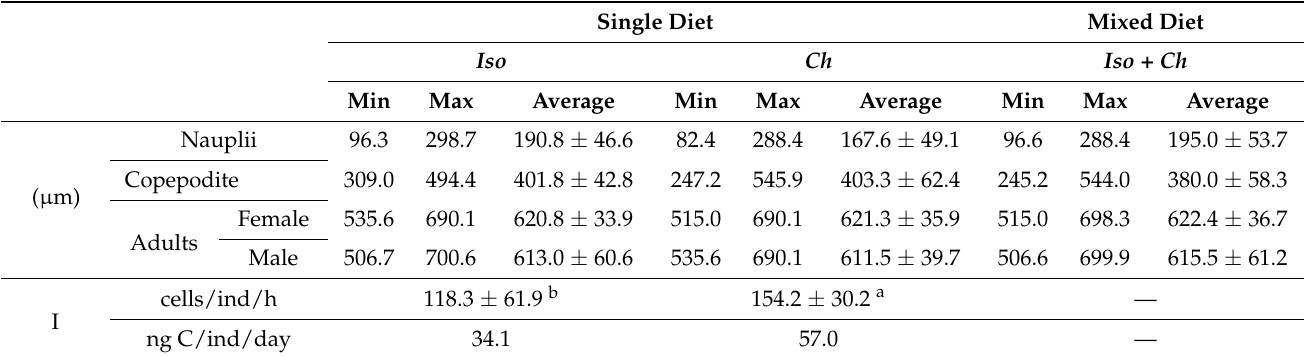
Table 3. Oithona nana individual growth ( µ m) of nauplii, copepodites, and females and males after 16 days in culture, and ingestion rate (I) of adults after 24 h in culture fed with single and mixed diets.